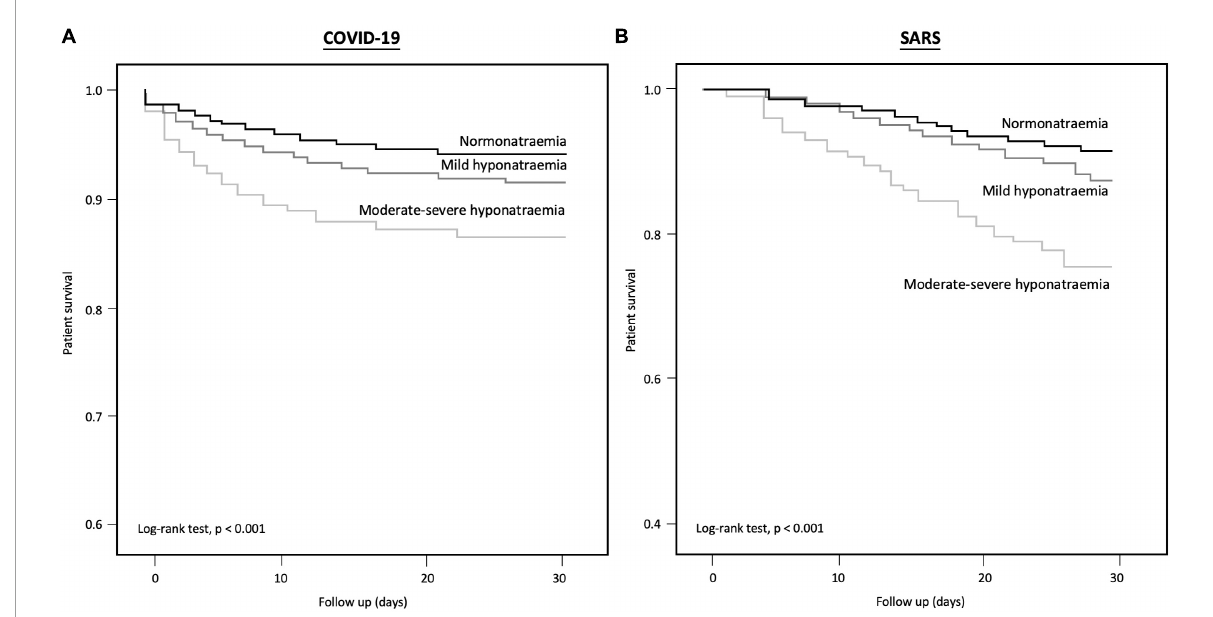
FIGURE2 Kaplan–Meier curve for 30-day survival in (A) COVID-19, and (B) SARS patients with normo-, mild hypo-, and moderate-severe hyponatraemia.